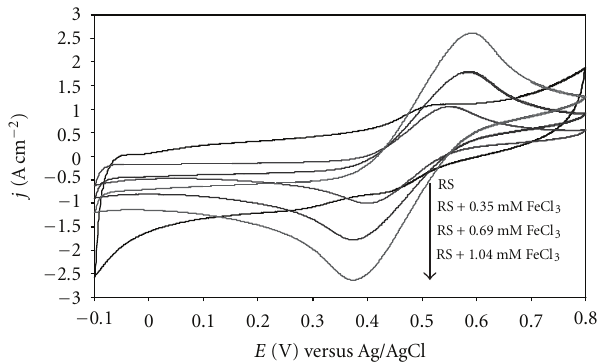
Figure 3: Cyclic voltammograms of real sample (RS) using GCE- MWCNT-PANI-Pt with di ff erent concentrations of FeCl 3 : 0.35, 0.69, and 1.04 mM, at 0.100 Vs − 1 in 0.1M KCl at 298 K.